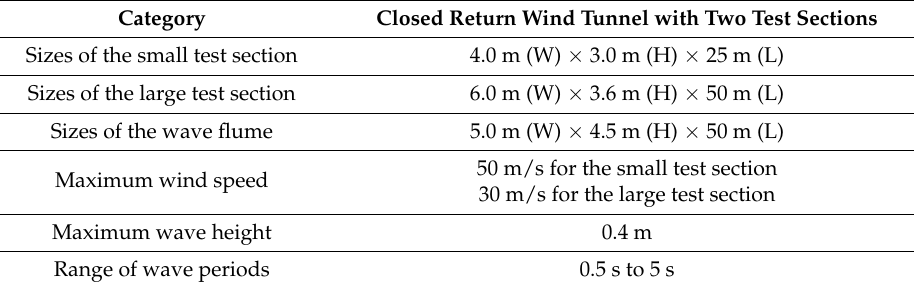
Table 3. Sizes and performance parameters of the WTWF joint laboratory. Figure 2. The wind tunnel and wave flume joint laboratory: ( a ) Plane diagram; ( b ) Small test section; ( c ) large test section.